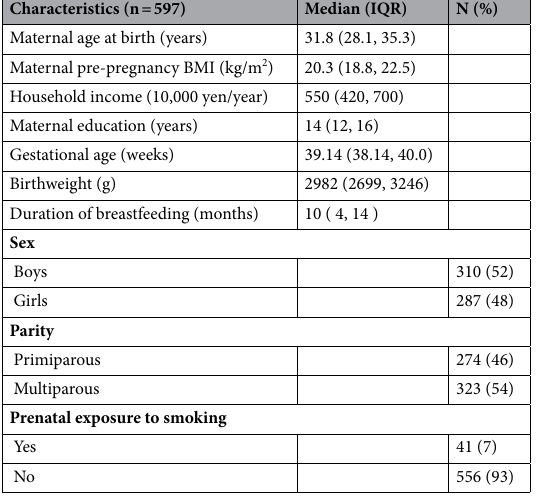
Table 1. Characteristics of the mothers (n = 534) and children (n = 597) participating in the